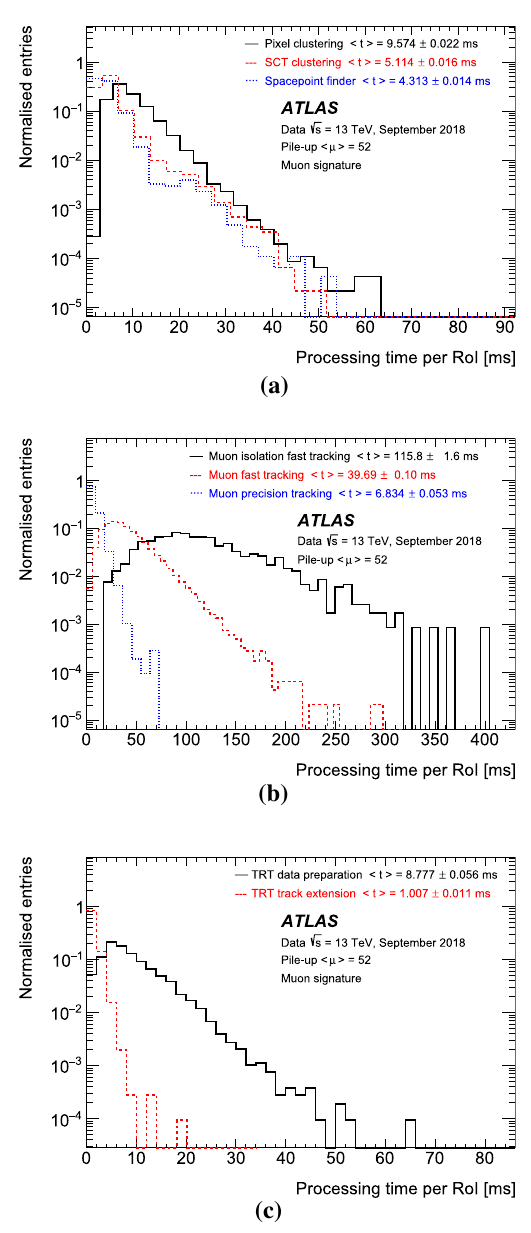
Fig. 10 The processing time for muon tracking related algorithms; a the data preparation times, b the tracking algorithm times, and c the TRT data